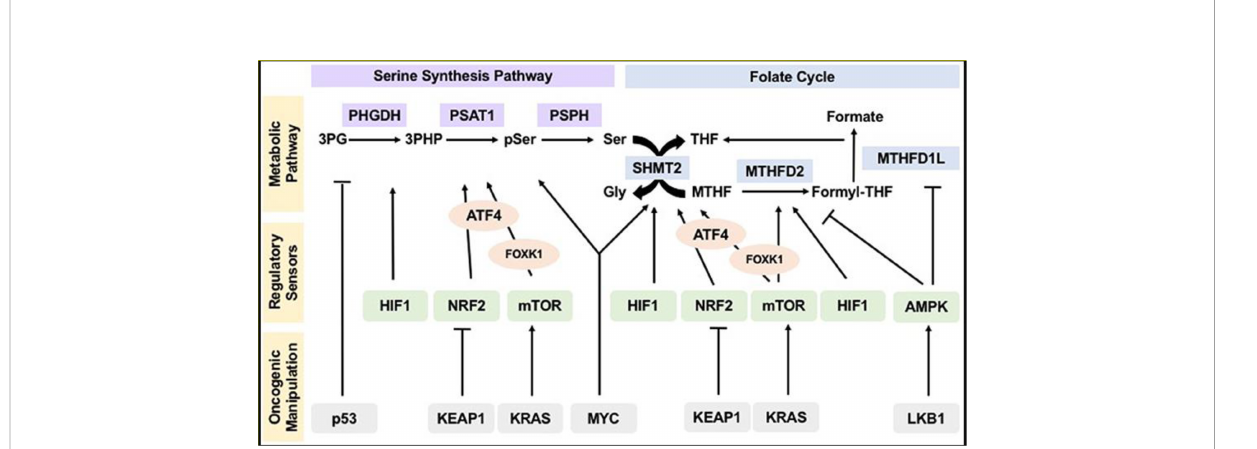
FIGURE 3 Oncogenic Manipulation, Regulatory Sensor, and Metabolic Pathways of the Serine Synthesis Pathway and Folate Cycle. Note. Sensors of nutrients and energy levels, AMP-activated protein kinase, rapamycin ’ s mammalian target, and reduction-oxidation potential sensors, NRF2 and HIF1, regulate various metabolic pathways. KEAP1, LKB1, tumor suppressor p53 KRAS, and the MYC modulate regulatory sensors, in fl uencing fl ux and operation pathways within the metabolic system. This allows hyperactivity which sustains tumorigenesis, proliferation, and the subsequent mutation or resistance to treatment.